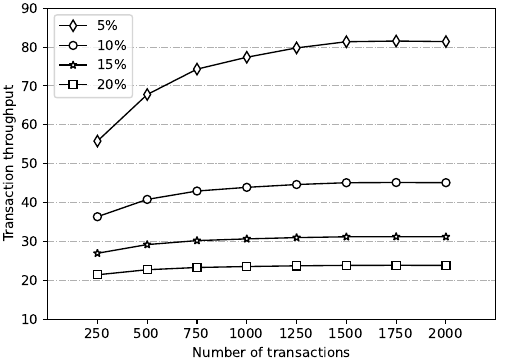
Figure 4. The transaction throughput under different transaction